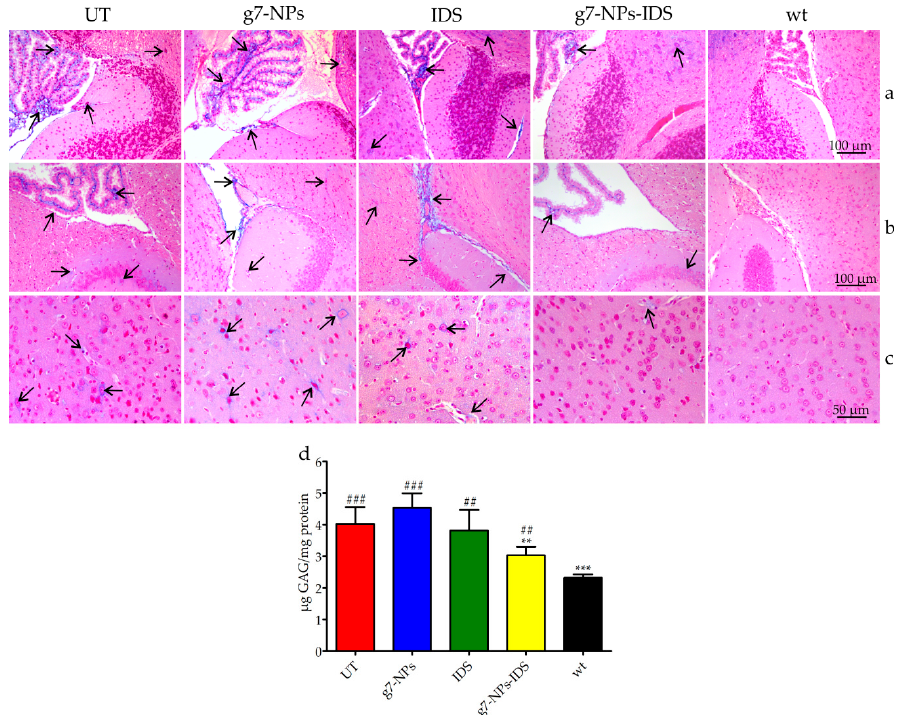
Figure 2. Analysis of GAG in the brain of treated Ids-ko mice. Histochemical and biochemical analysis of GAG in the brain of Ids-ko mice treated with 0.9% NaCl (untreated, UT), g7-NPs, free IDS, g7-NPs-IDS, and in wt mice, after 6 weeks of treatment. Representative sections of the brain storages in (a) cerebellum with the fourth ventricle, (b) hippocampus with the third ventricle, and (c) cerebral cortex. Arrows indicate GAG deposits. Sections (7 μ m) were stained with 1% Alcian Blue pH 2.5, counterstained with 0.1% Nuclear Fast Red. (d) GAG content ( μ g GAG/mg protein) detected in the brain parenchyma after 6 weeks of treatment ( n = 5 per treatment group). All values are represented as mean ± SD. Asterisks indicate a statistically significant di ff erence from UT mice (Mann–Whitney U test, ** p < 0.01, *** p < 0.001); hash marks indicate a statistically significant di ff erence from wt mice (Mann–Whitney U test, ## p < 0.01, ### p <